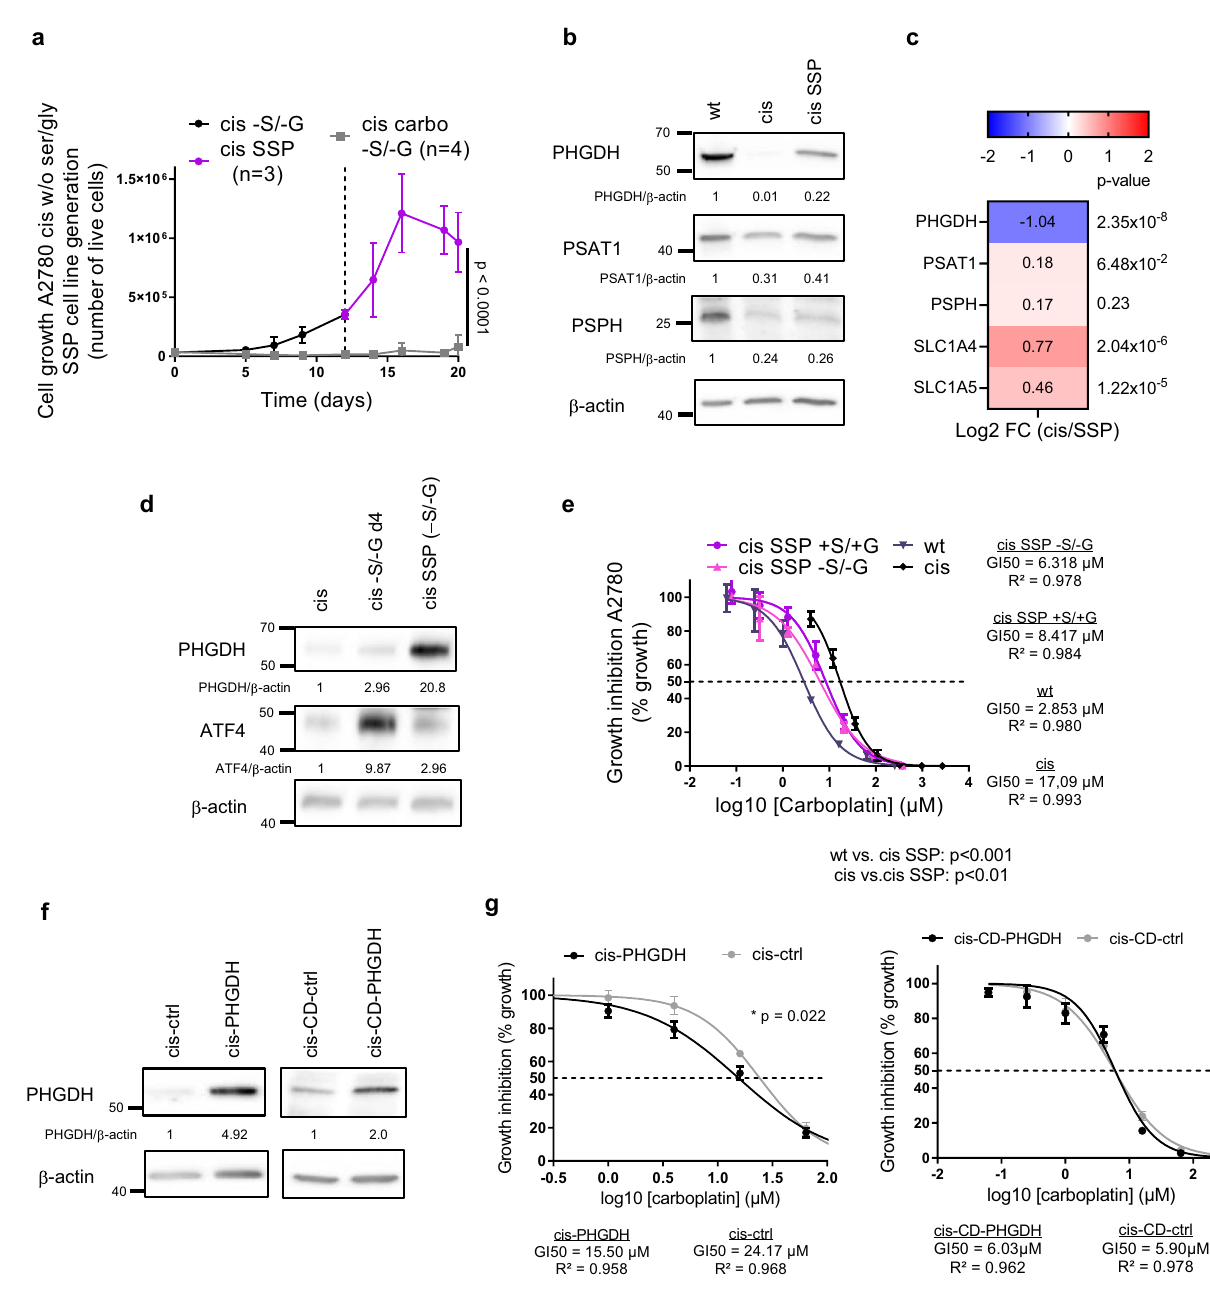
Fig. 3 | Serine biosyntheticactivitycorrelates withplatinum responsivenessin A2780 resistant cells. a Generation of cis SSP cell line established after serine/ glycine deprivation of cis cells, n =3 biological replicates for cis cells, n =4 biolo- gical replicates for cis carbo cells (with three technical replicates each time), repeated measures two-way ANOVA, data are represented as mean±SD. b Representative western blot of serine biosynthetic enzymes, n =4 biological replicates. c RNA-seqresultsofserine biosyntheticenzymesand maintransporters incisSSPcells,meanvaluesareplotted, n =3technicalreplicates, p valuesobtained by DESeq2 (Wald-test with Benjamini and Hochberg multiple testing). d Representative western blot of PHGDH and ATF4 in cis cells, serine and glycine starvedciscellsandSSPcells, n =2biologicalreplicates. e GI50curvesofwt,cisand cis SSP cells, n =3 biological replicates (with three technical replicates each time),